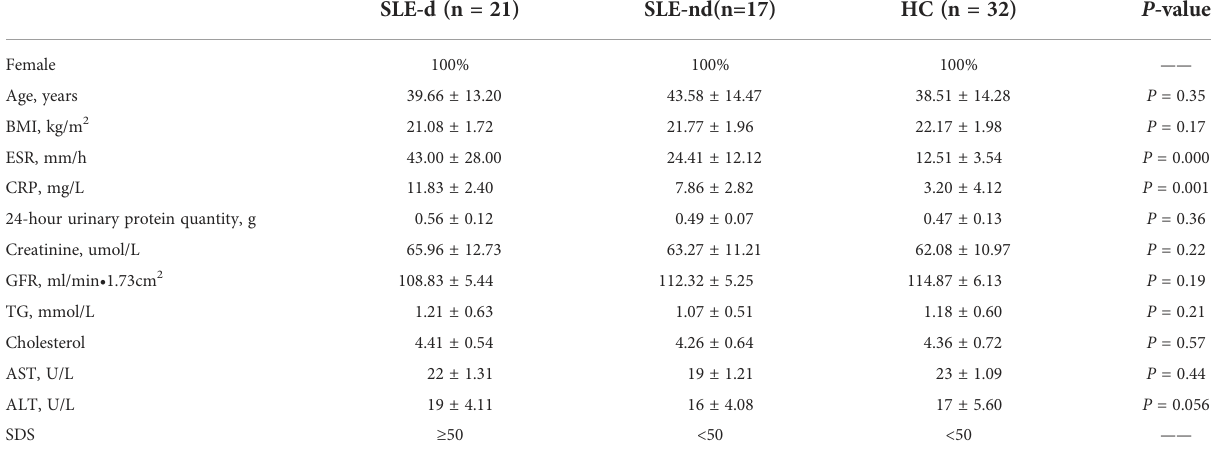
TABLE 1 Characteristics of the